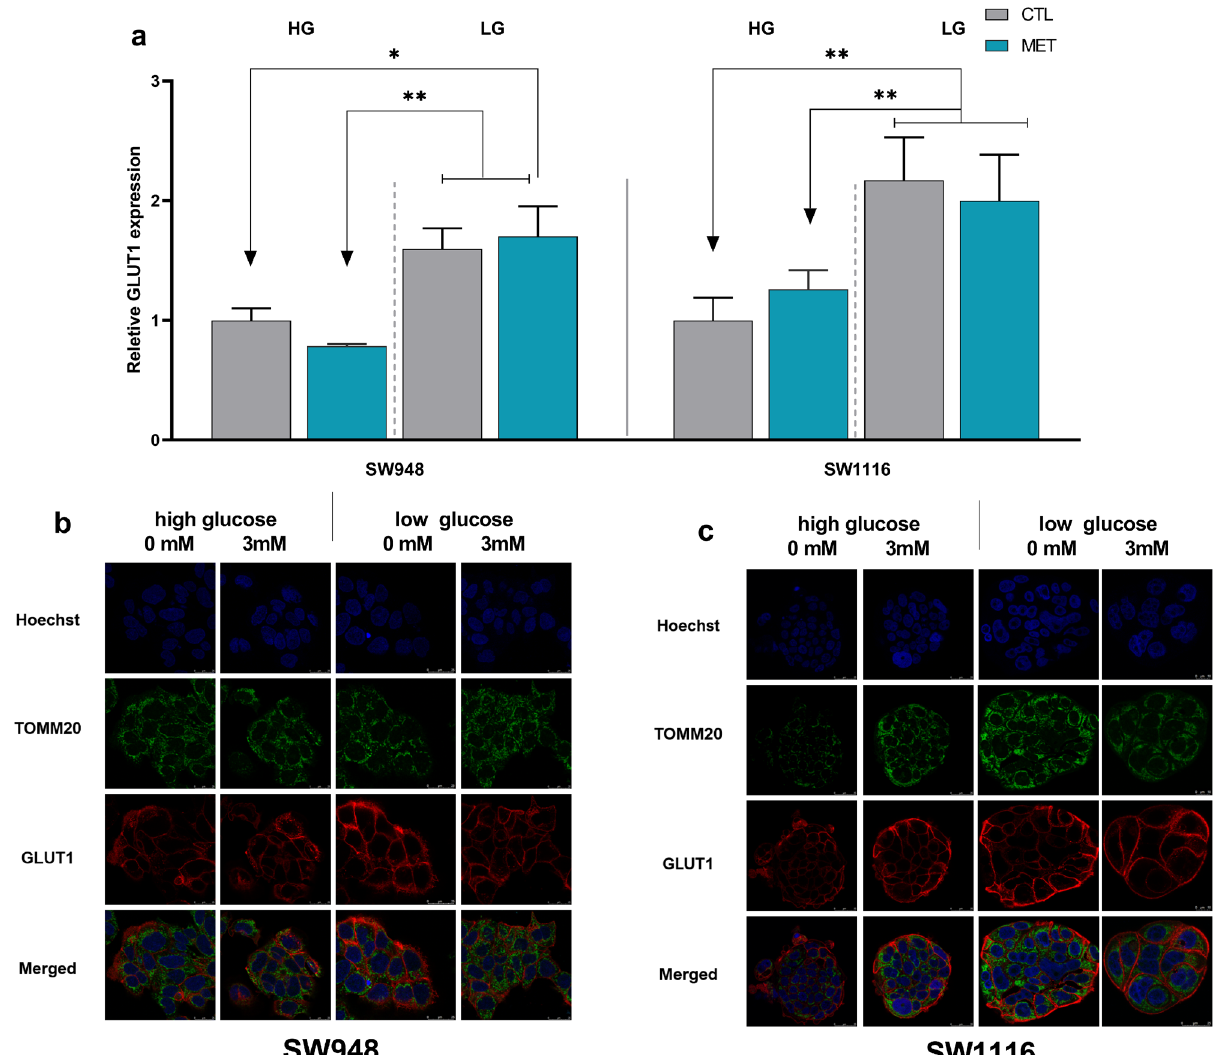
Figure 4. Protein expression analysis of GLUT1 in response to metformin treatment under different glucose culturing conditions. ( a ) Bars represent the relative GLUT1 fold inductions, measured by flow cytometry after 48 h metformin treatment in SW948 and SW1116, compared to respective controls at same glucose culturing conditions. Representative confocal images of ( b ) SW948 and ( c ) SW1116 using Hoechst for nuclei staining in blue, TOMM20 for the mitochondria in green, and GLUT-1 Antibody in red. Error bars denotes s.e.m. and statistical analysis was calculated using two-way ANOVA (*p < 0.05, **p < 0.01) (N = 3). MET Metformin, CTL control, GLUT1 glucose transporter